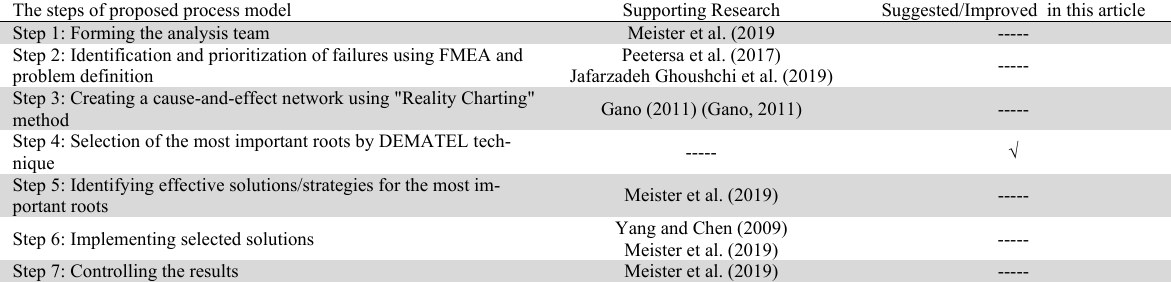
The evidences for verification of proposed process model